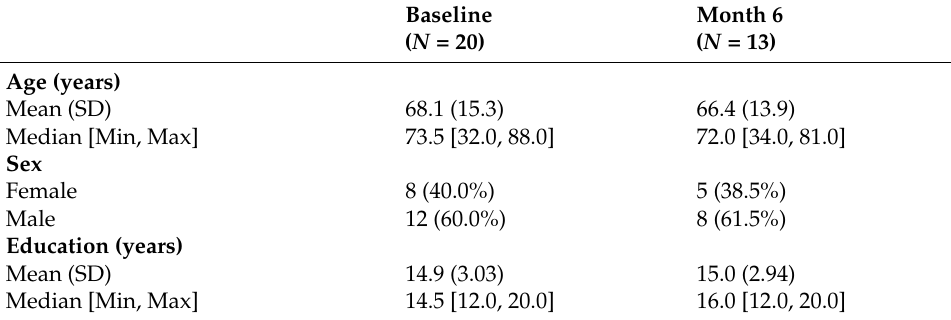
Figure 1. Consort diagram. * Curated Clinical Outcomes Database. Table 3. CPI group demographics baseline vs. month 6.